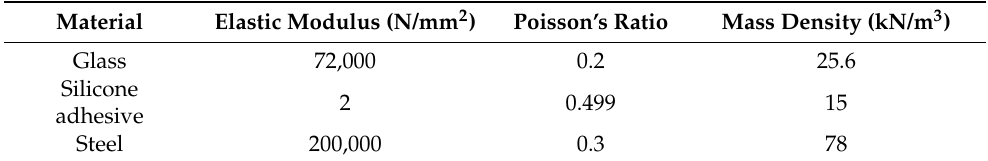
Figure 3. The FE model of the LGCW. Table 1. Material parameters.